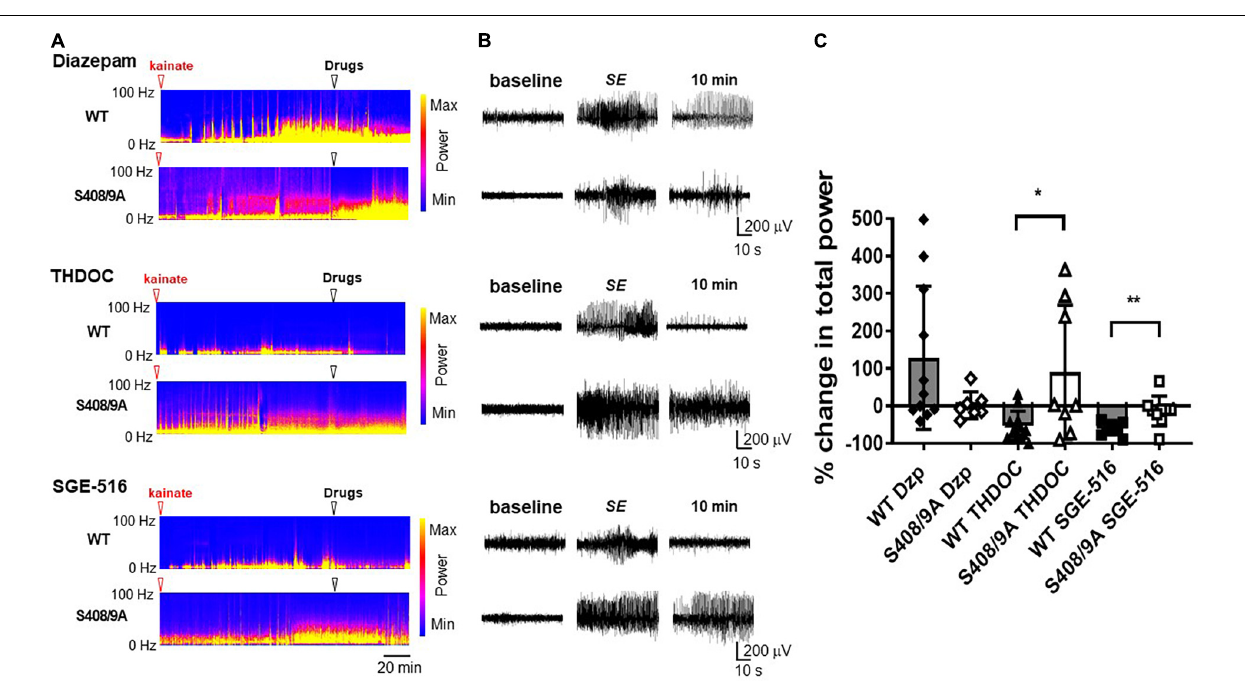
FIGURE 4 | Neuroactive steroids are ineffective in terminating diazepam resistant seizures in S408/9A mice. (A) EEG spectrograms from WT and S408/9A mice following injection with 20 mg/kg kainate (red arrowhead) to induce Status Epilepticus (SE). 60 min after entrance into SE, mice were then injected i.p . (white arrowhead) with diazepam (Dzp, 20 mg/kg), THDOC (100 mg/kg), or SGE-516 (3 mg/kg). (B) EEG recordings from WT and S408/9A mice during baseline, SE, 10 min following drug administration demonstrating diazepam resistant seizures that are suppressed with THDOC or SGE-516 in WT but not S408/9A mice. (C)